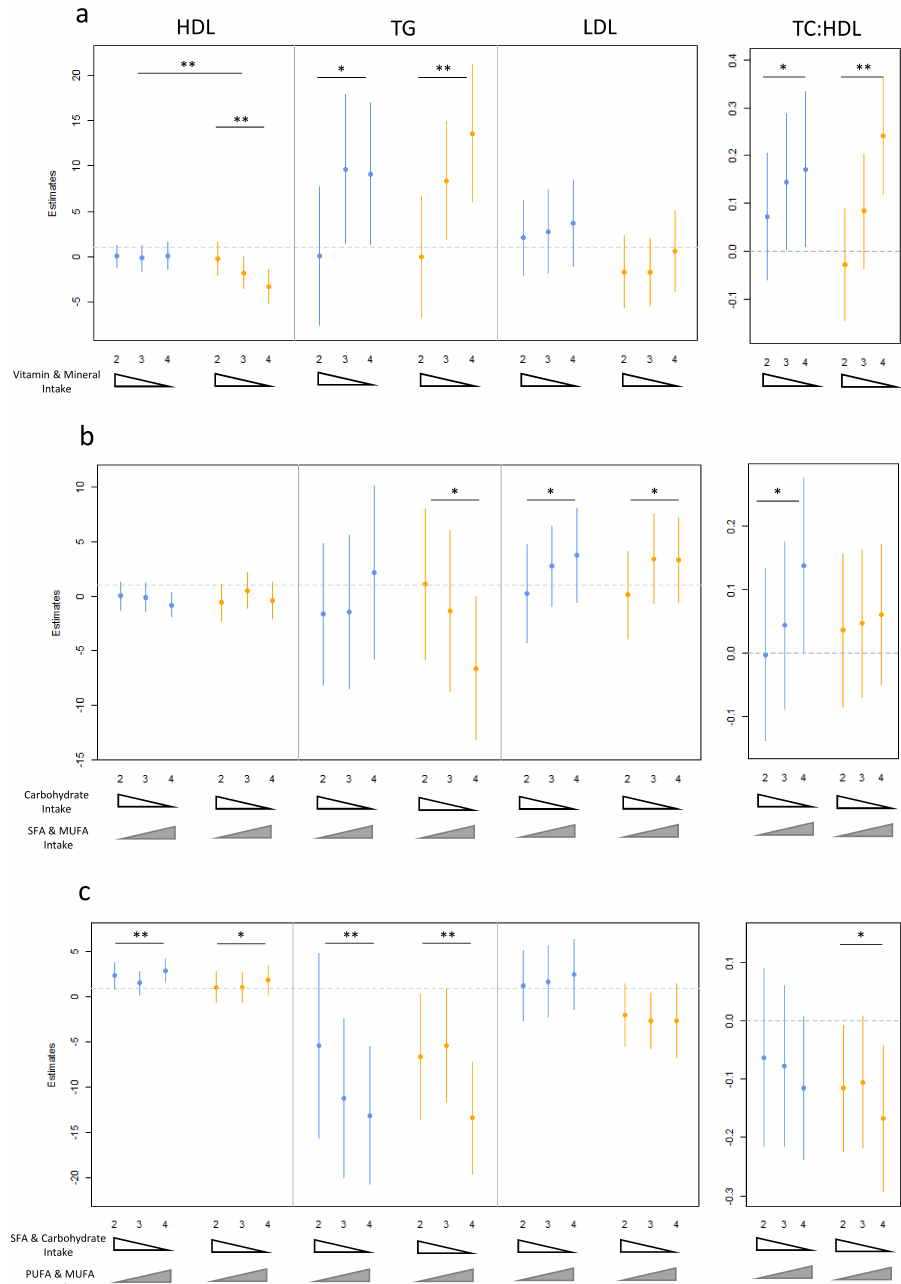
Figure 1. Gender stratified multivariable-adjusted linear association plots (beta co-efficient, 95% confidence interval) of correlation between lipid levels (high density lipoprotein (HDL cholesterol), triglycerides (TG), low density lipoprotein (LDL cholesterol), and total cholesterol to HDL cholesterol ratio (TC:HDL cholesterol)) among dietary pattern quartiles. ( a ) PC1 was correlated with vitamin, mineral, fiber, and protein intake. ( b ) PC2 was correlated with carbohydrate vs. saturated fatty acid (SFA) and monounsaturated fatty acid (MUFA) consumption. ( c ) PC3 was correlated with SFA and carbohydrate vs. polyunsaturated and monounsaturated fatty acid intake. Male and female analyses are shown in blue and orange, respectively. Results are presented as quartile 1 relative to quartiles 2–4 (Q2–4). Triangles below each panel represent the direction of increasing nutrient intake. For example, vitamin and mineral consumption A decreases with each quartile. Double asterisks represent significant associations ( p Bonferroni < 0.00208) between lipid levels and quartile status assuming an additive model. Single asterisks represent trending associations (0.00208 < p Bonferroni < 0.05) under the same